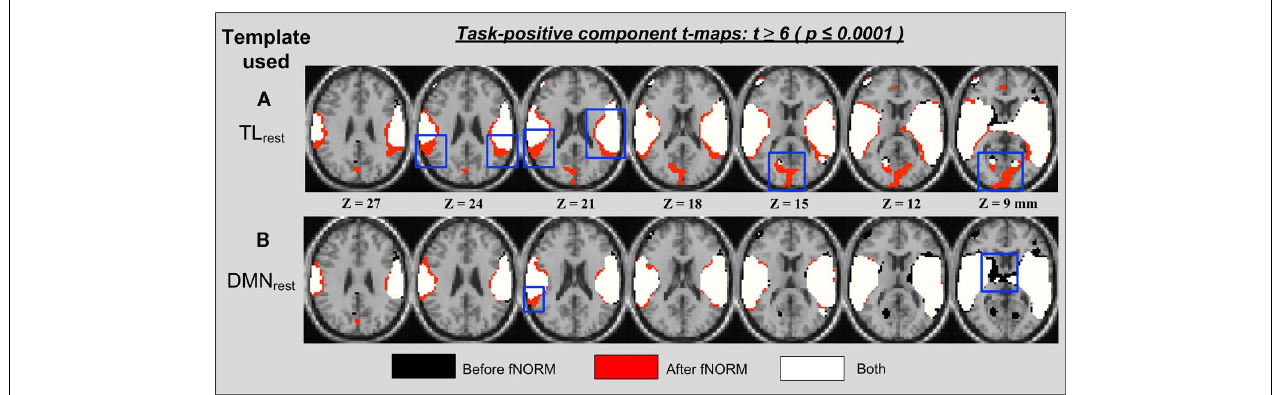
FIGURE 6 |Thresholded activation maps ( t > 6, p < 0.0001) for theTL AOD component from ICA analysis ( n = 28) showing overlapping and differential regions obtained “before” and “after” ICA-fNORM ofAOD data done using different templates: (A)TL rest , (B) DMN rest . Each method is